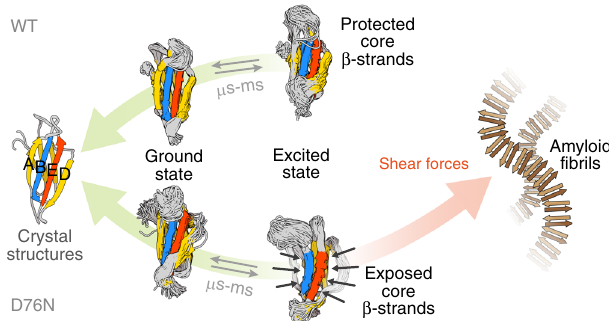
Fig. 7 Proposed mechanism for the fi rst steps of D76N aggregation. Under native conditions both wt and D76N are in equilibrium between low and high-energy conformations. While wt high-energy conformation has a contained aggregation propensity, the D76N excited state is less structured, highly dynamic, and exposes highly aggregation-prone regions shown in orange. Thus, modest energies such as shear forces present in the circulation system are suf fi cient to further unfold D76N β 2m termini (model) destabilizing completely β 2m fold and leading to